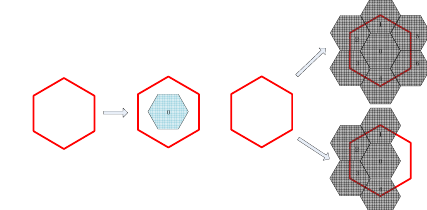
Figure 5. The first subdivision process